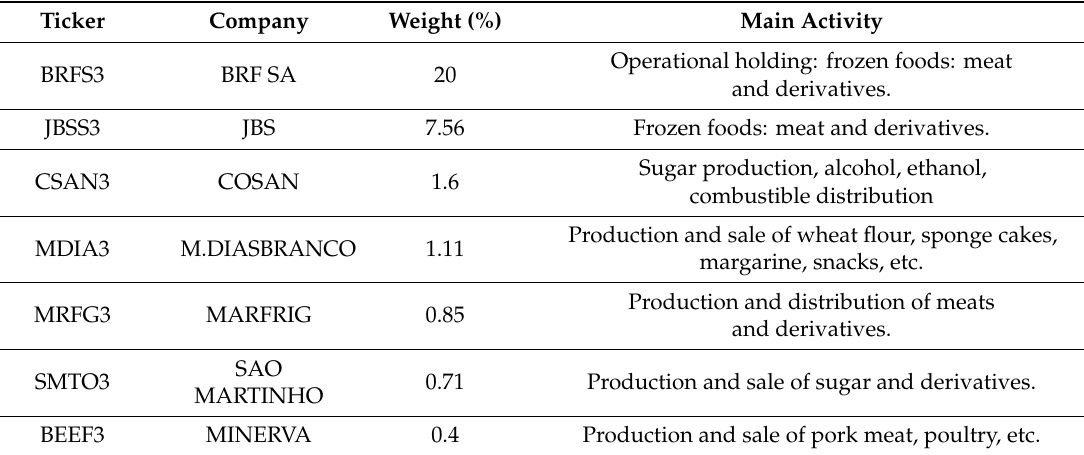
Table 1. Sample of agri-food companies.